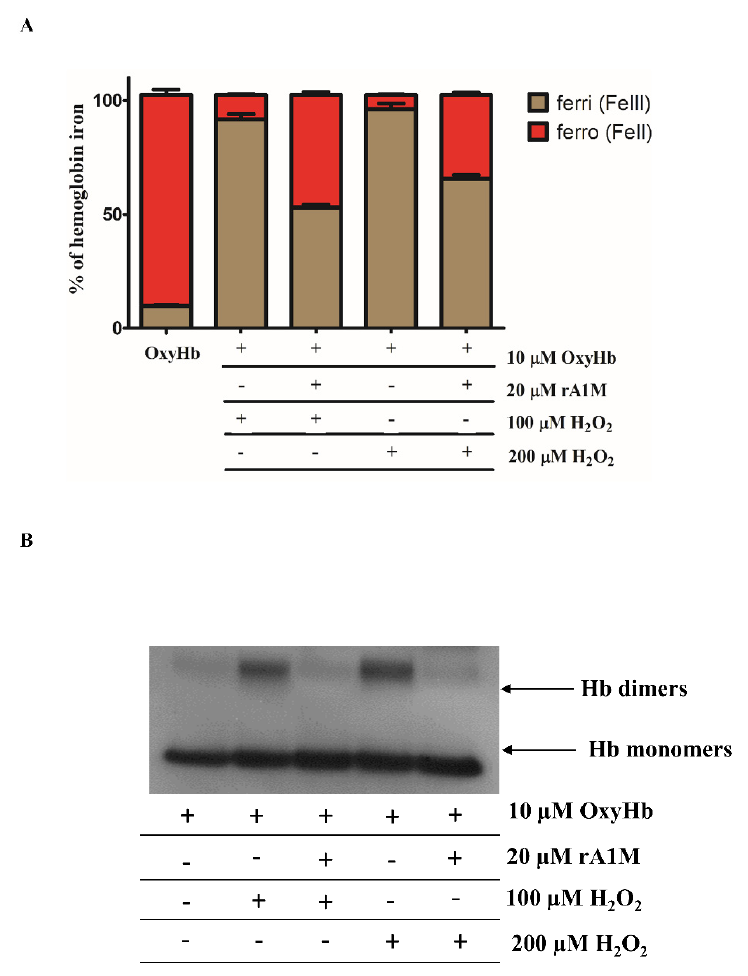
Figure 5. Recombinant A1M (rA1M) inhibits hemoglobin oxidation. Purified OxyHb (10 µM) was incubated for 3 h at 37 °C with 100 or 200 µM of H 2 O 2 in the presence or absence of rA1M (20 µM). ( A ) Amounts of different redox states of Hb were determined by analysis of the visible spectra. The presence of different redox states of Hb as a percentage of total heme was calculated. ( B ) Representative immunoblot showing covalently cross-linked Hb multimers after Hb oxidation.